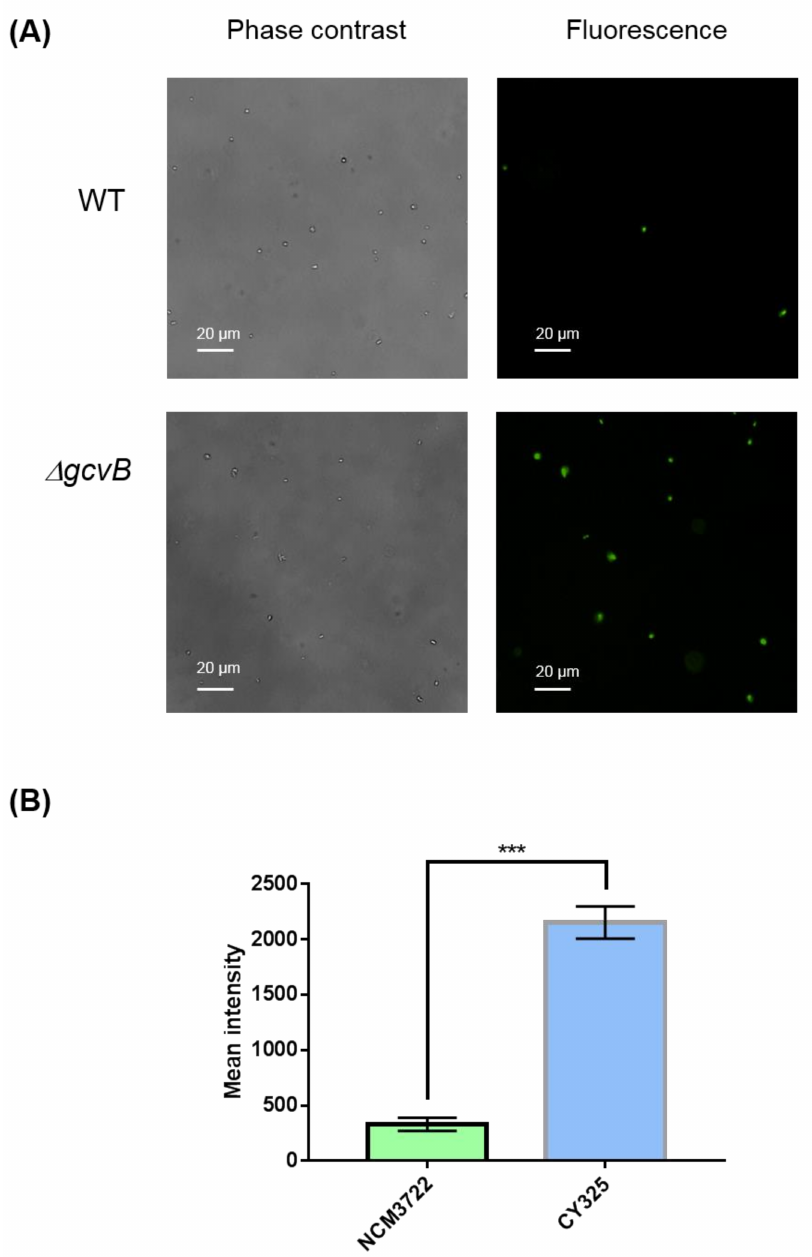
Figure 7. Detection of peroxide. ( A ) Detection of peroxide by H 2 DCFDA staining. The phase contrast shows the cells under microscope and the green fluorescence represents the detection of peroxide. Two to three independent observations were performed and one image containing representative cells is shown. ( B ) Quantification of fluorescence intensity. Fluorescence intensity was expressed as the average ± S.E.M., calculated from 468 to 741 individual cells. NCM3722 (WT); CY325 ( ∆ gcvB ). *** p < 0.001 using Student’s t